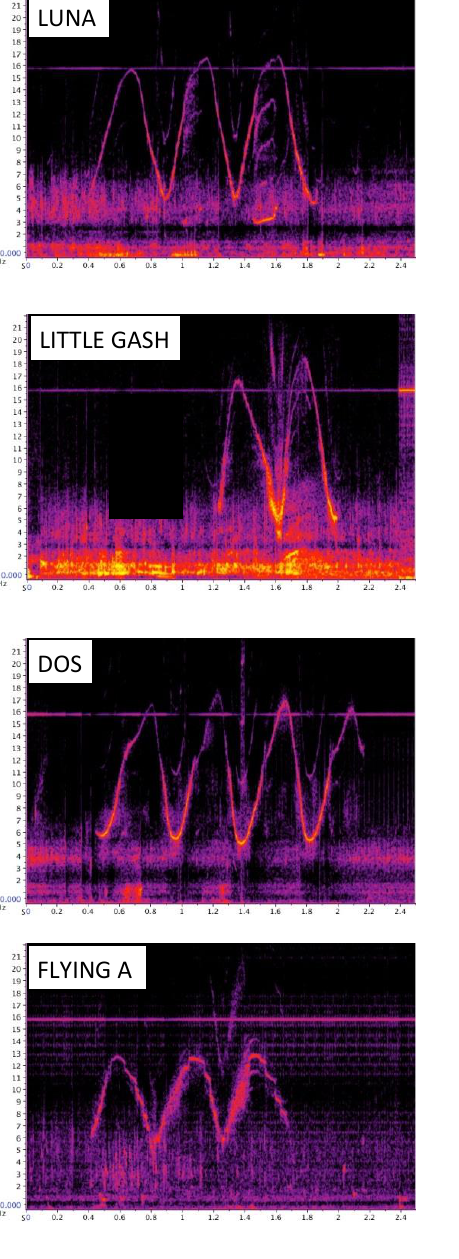
Figure 1. Representative spectrograms of the mother-offspring pairs determined to be most and least similar by judge scoring: Luna and male offspring Latitude (3.50), Little Gash and female offspring Little Hali (3.33), Dos and male offspring Ditto (1.67), and Flying A and female offspring KP (1.75)